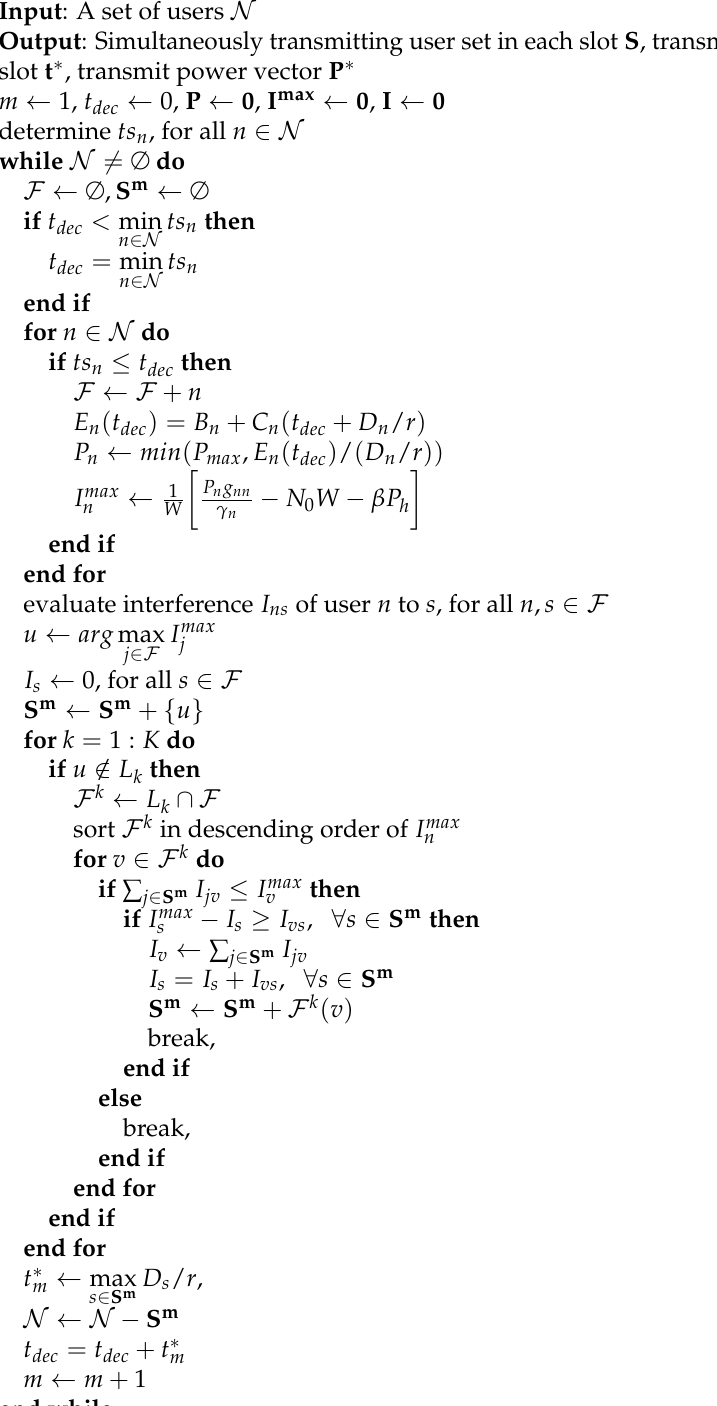
Algorithm 1 Constant Rate Scheduling Algorithm